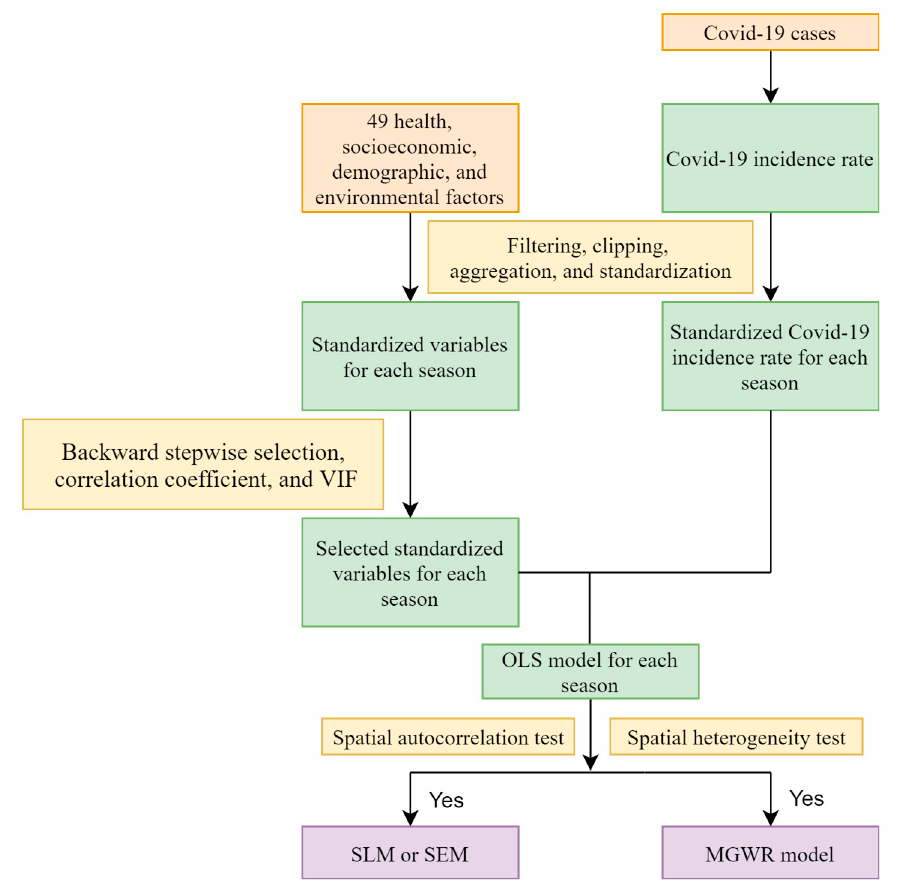
Figure A1. Flowchart of the method.